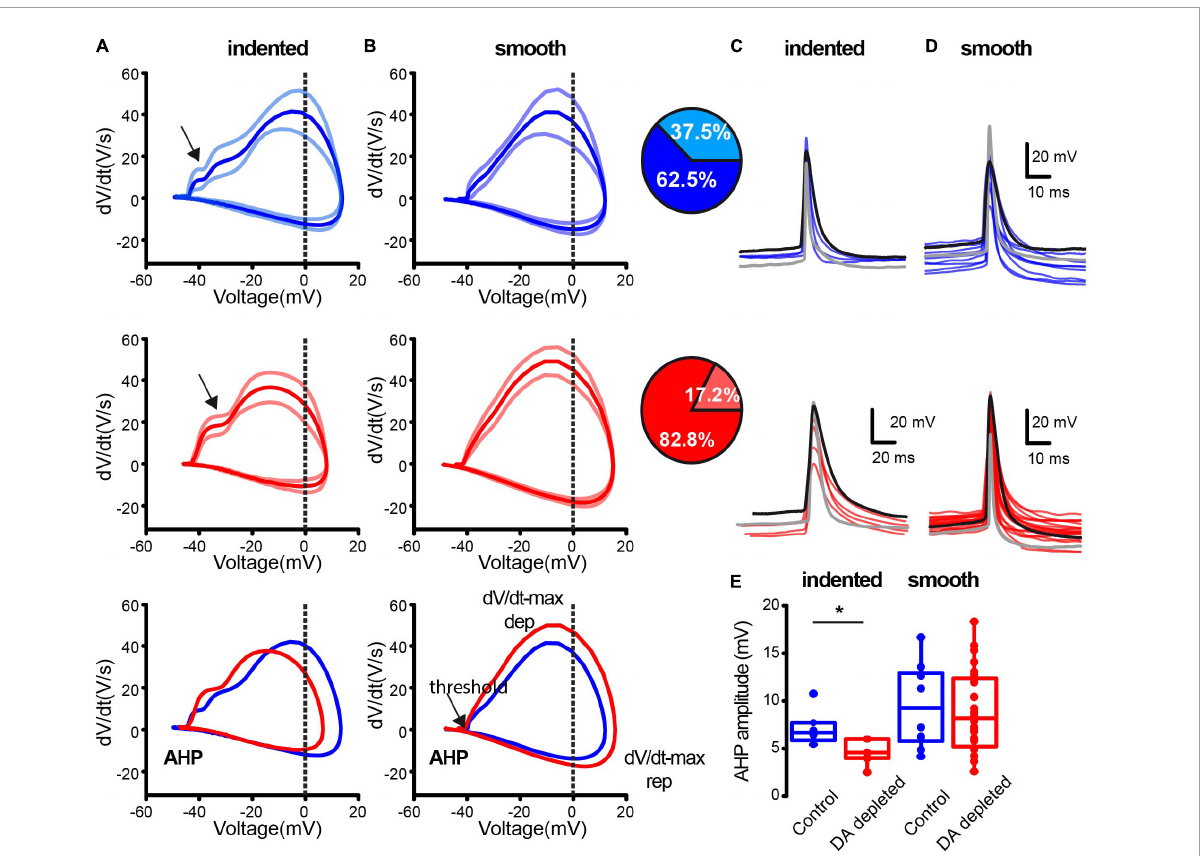
FIGURE5 The extremes of a continuous spectrum of action potentials (APs) waveforms within the striatal population of cholinergic interneurons. (A) CINs with a clear indentation during AP depolarization as revealed by dV/dt(V)-plots (arrows). (B) CINs with a smoother depolarization during their AP. Top (blue) traces correspond to APs in control conditions and middle (red) traces correspond to APs from DA-depleted neurons. APs were chosen during spontaneous firing at a similar frequency and membrane potential was measured at the threshold. The dV/dt(V)-plots are illustrated as means ± standard error of the mean (SEM). Bottom traces in (A,B) superimpose means from control and DA-depleted neurons (Control-indented n = 6; Control-smooth n = 10 cells from 7 different animals; DA depleted- indented = 5; DA depleted –smooth n = 25 cells from 14 different animals). Insets: pie plots show the percentage of indented plots during AP depolarization in paler color; more neurons with indentation during depolarization of APs are present in control conditions ( P = 0.0001; df = 1; χ 2 ). (C) Stacked APs averaged from different neurons from indented AP depolarization in control (blue) and during DA depletion (red). (D) Superimposition of averaged APs without indentation. (E) Shown differences are non-significant except for AHP amplitude in indented samples (* P = 0.03; Mann–Whitney U